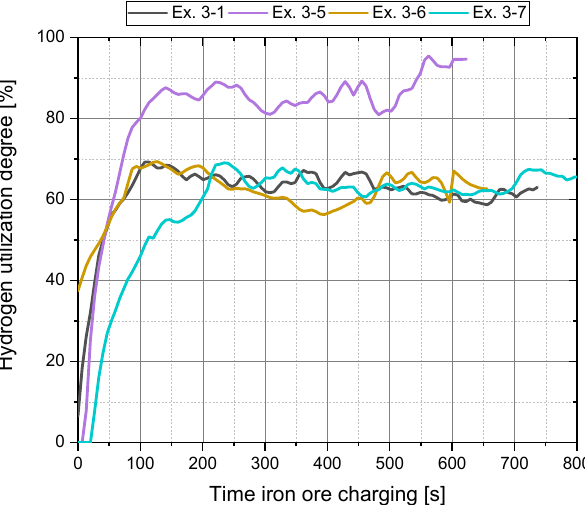
Figure 12. Hydrogen utilization during charging (Phase 4) for Ex. 3–1 and Ex. 3–5 to Ex. 3–7.